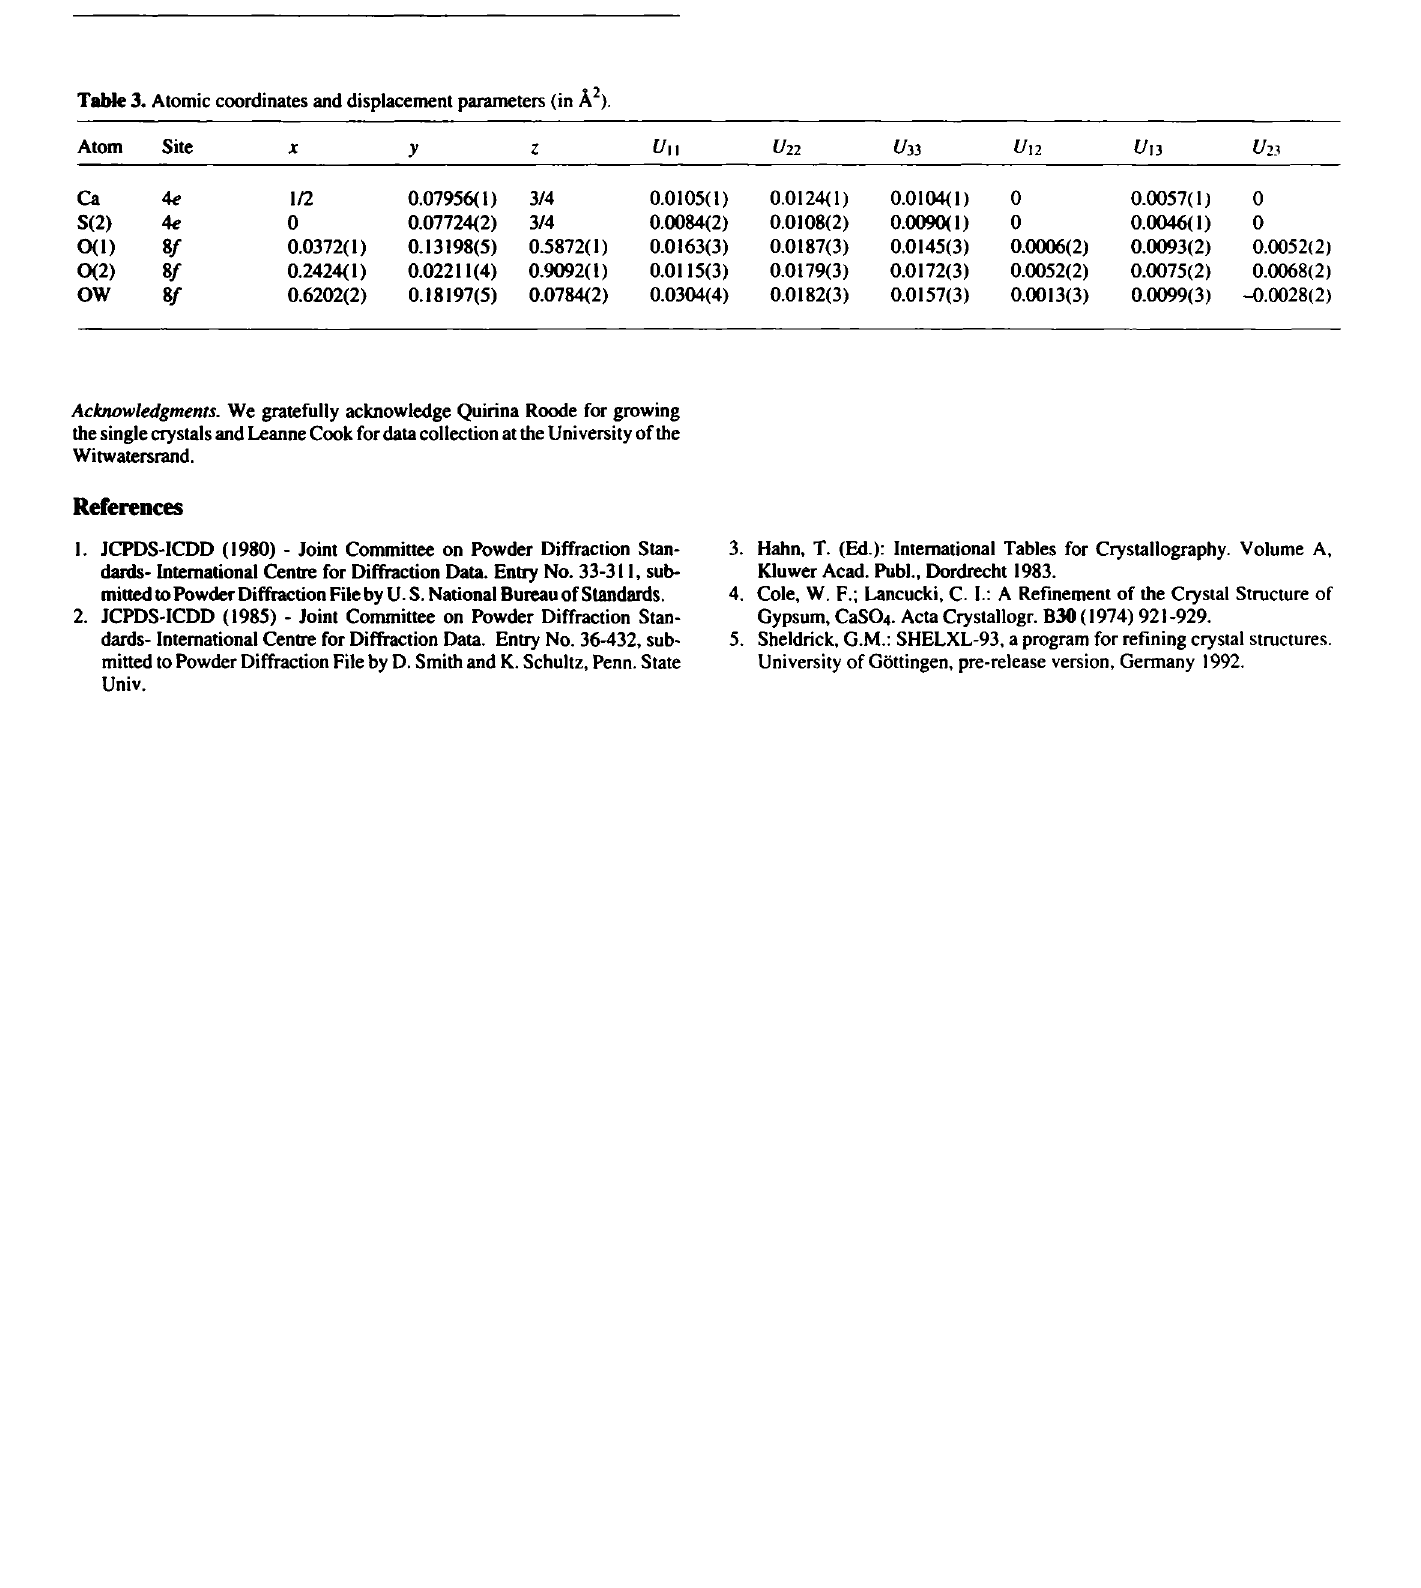
Table 3. Atomic coordinates and displacement parameters (in Â 2